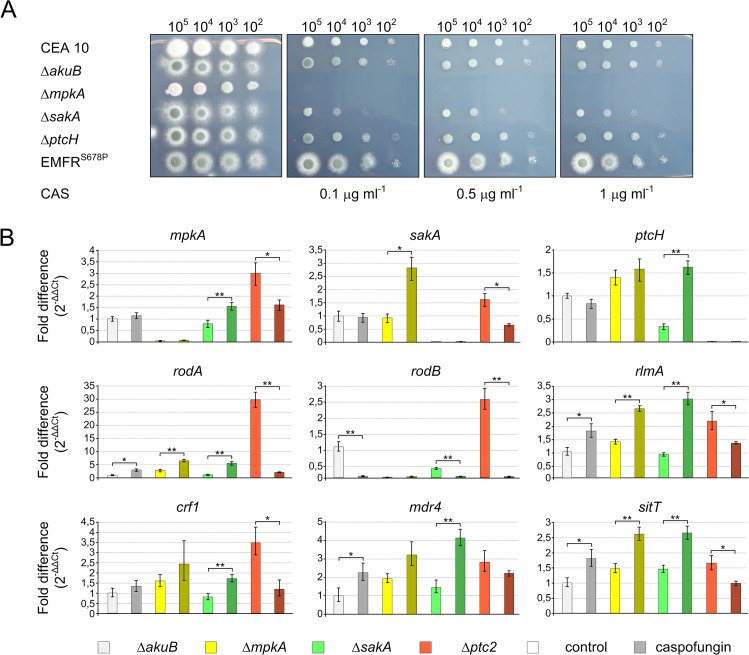
Validation of cross talk between MAPKs.A) The reported strains were tested against caspofungin (CAS) at different concentrations. The indicated number of conidia was spotted on AMM agar plates and incubated at 37°C for 48 hours. B) Results of the qRT-PCR analysis for selected genes in the ΔakuB, ΔmpkA, ΔsakA and ΔptcH mutant strains are shown. Total RNA was extracted before (T0) and 4 h after caspofungin induction (T4). In all performed experiments, the fold changes for each gene were obtained applying the 2-ΔΔCt method (reported in the y axes). Data ± SDs. Statistical significance was determined for all the experiments by a Student’s t test. Significance of differences of data with P<0.005 (*) and P<0.001 (**) is indicated. qRT-PCR data for each strain are marked in different colours, as indicated below. Empties bars indicate expression levels for untreated samples, while treated samples are speckled.